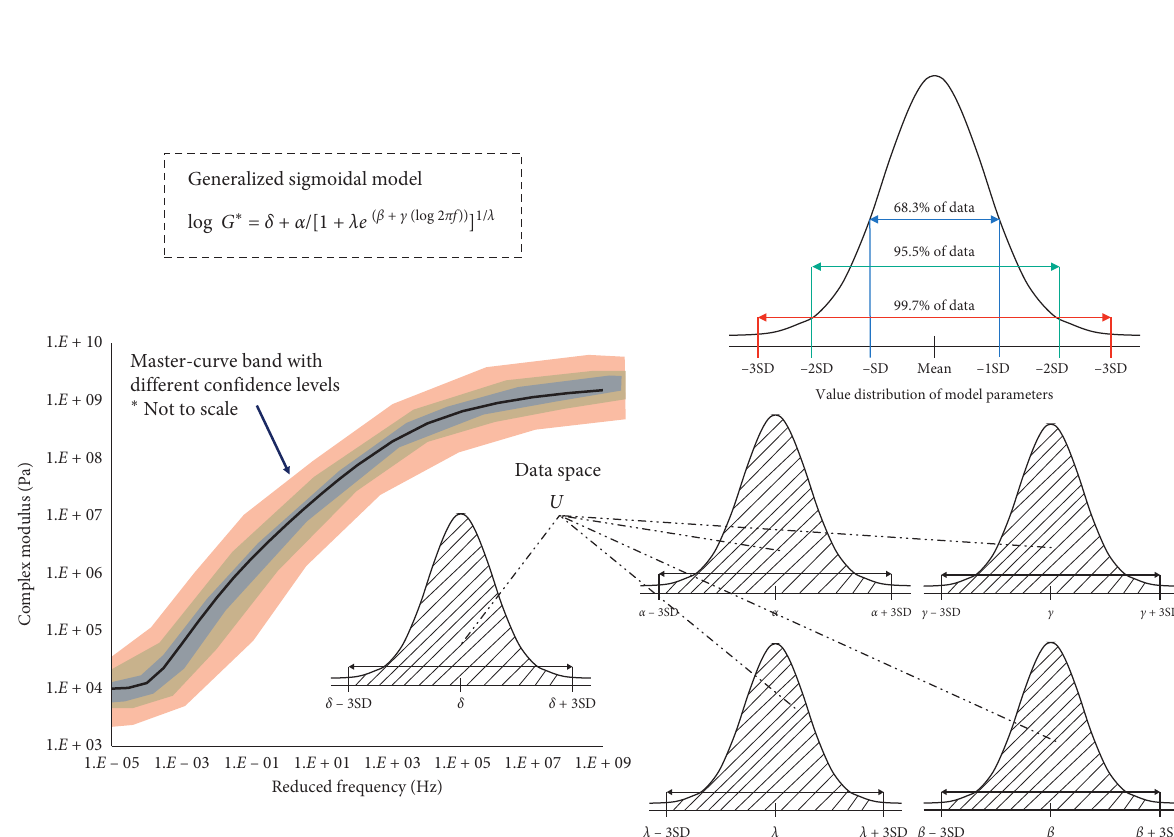
Figure 4: Extension from master curve to MCBs (example: generalized sigmoidal model).